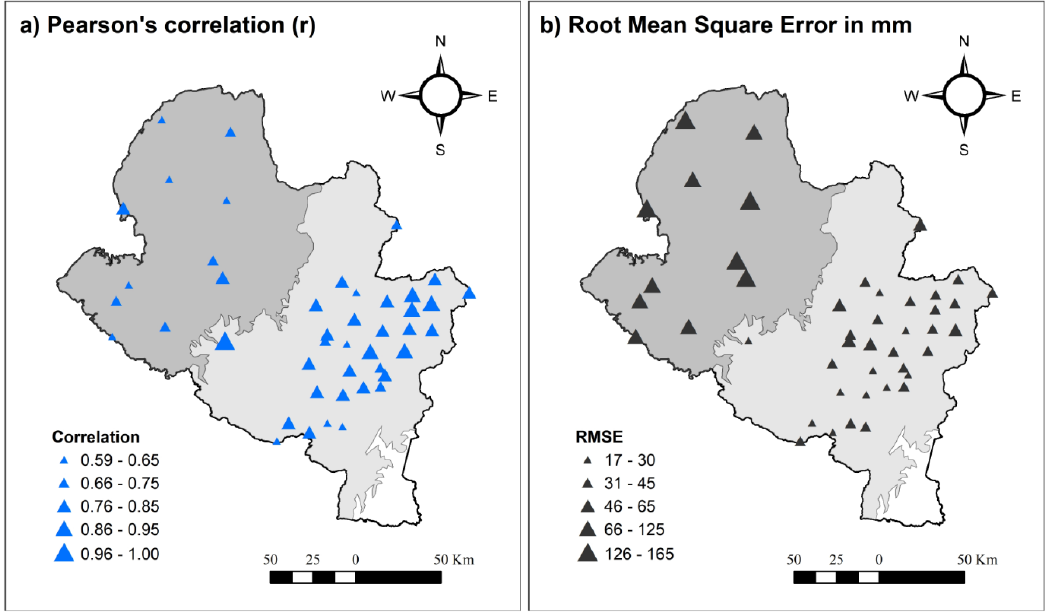
Figure 11. Comparison of the original and forecasted series of rainfall anomalies using the Simplified-NNARMAX model. ( a ) Pearson’s correlation (r), and ( b ) Root Mean Square Error in mm.